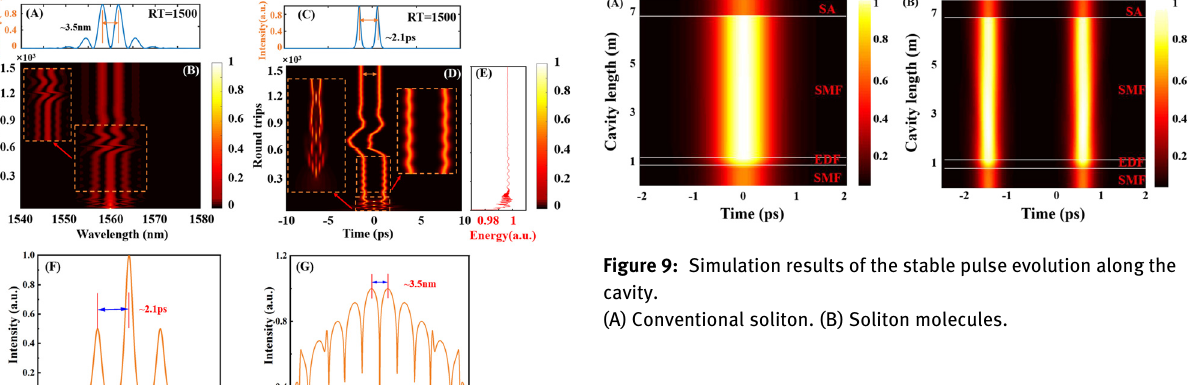
Figure 6(A) well. The generation process of soliton mole- cules is similar to previous literature reports [56].